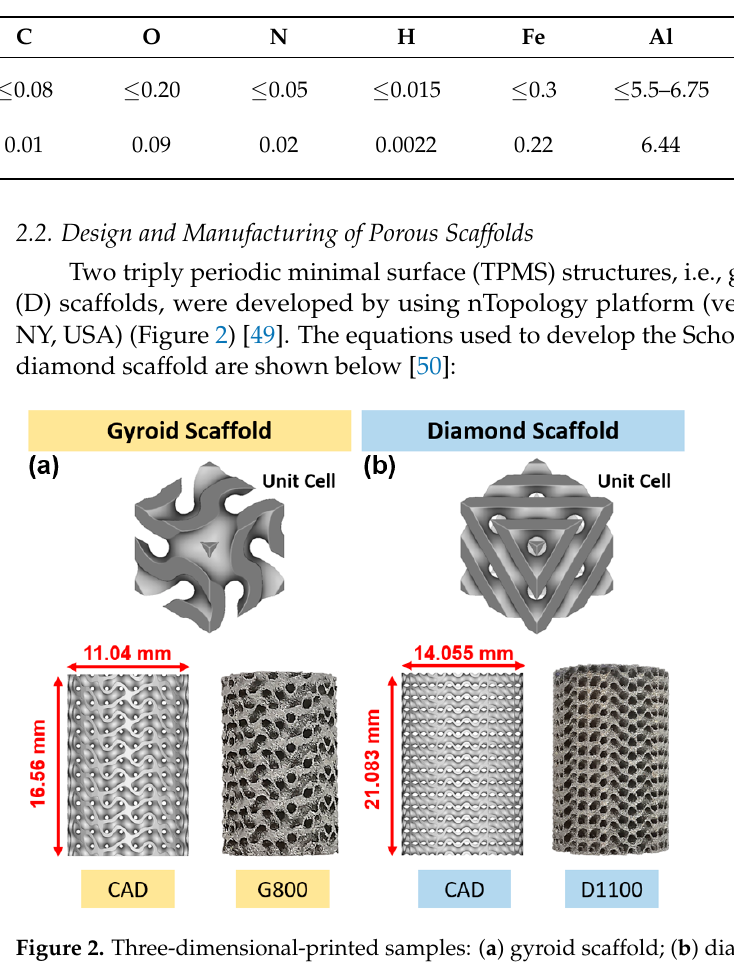
Table 2. Chemical composition of Ti6Al4V powder used in this study.